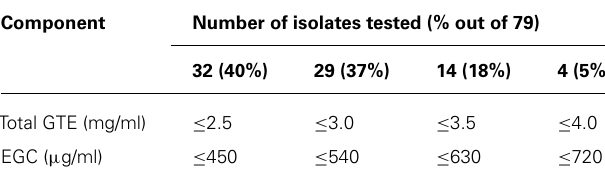
Table 2 | Minimum inhibitory concentrations for total green tea extract (GTE) and the EGC component. Component Number of isolates tested (% out of 79) 32 (40%) 29 (37%) 14 (18%) 4 (5%) Total GTE (mg/ml) ≤ 2.5 ≤ 3.0 ≤ 3.5 ≤ 4.0 EGC ( μ g/ml) ≤ 450 ≤ 540 ≤ 630 ≤